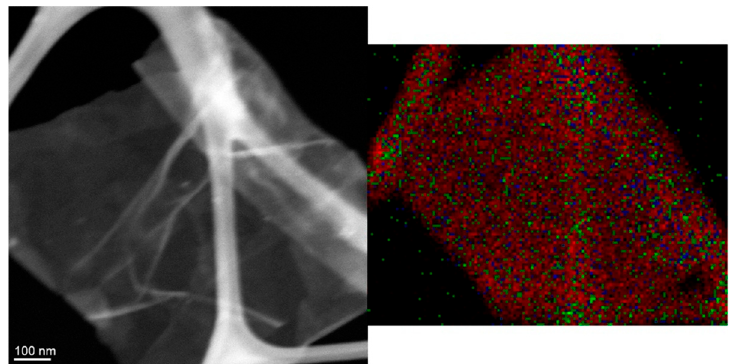
Figure 4. STEM-EDS elemental mapping image of mRGO, red, green, and blue dots indicate carbon, sulfur, and oxygen atoms,